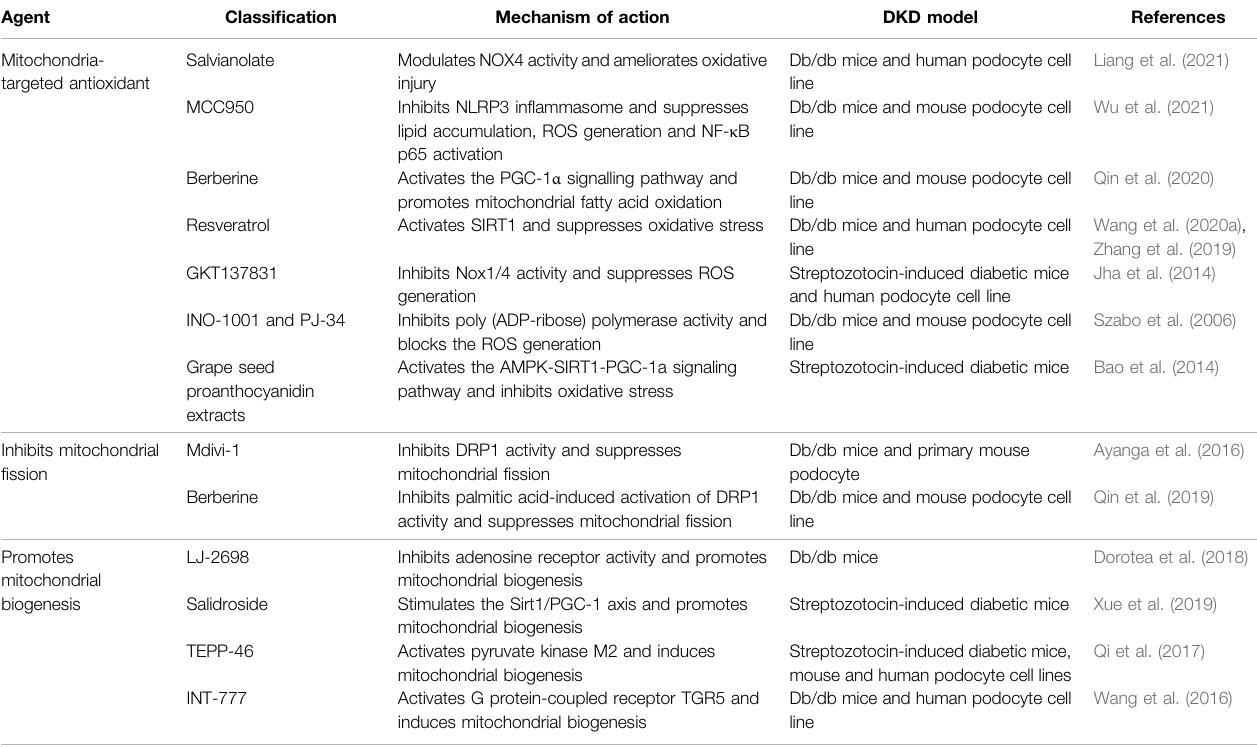
TABLE 2 | Potential approaches to target podocyte mitochondrial dysfunction in preclinical